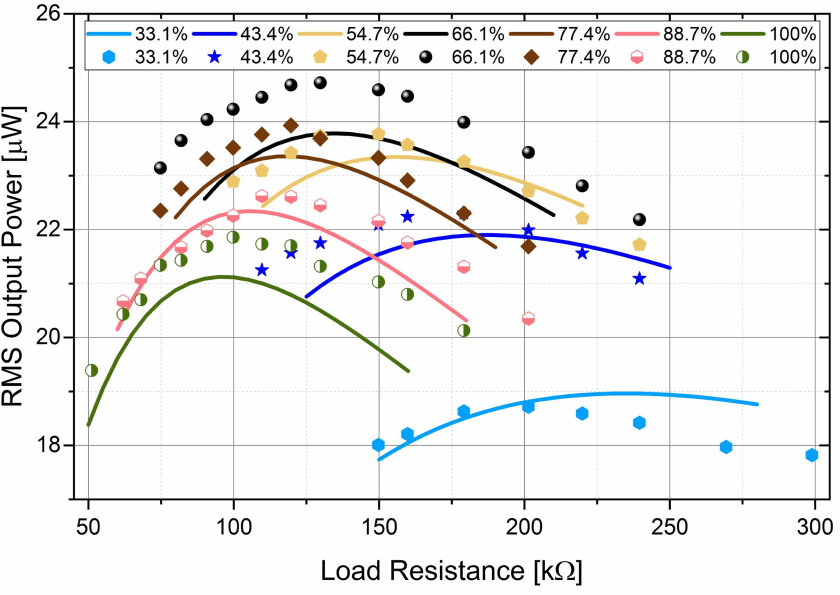
Figure 9. RMS output versus load resistance for different electrode coverage ratios. The solid lines and marks are theoretical and experimental results, respectively. Identical colors are applied to the same electrode coverage